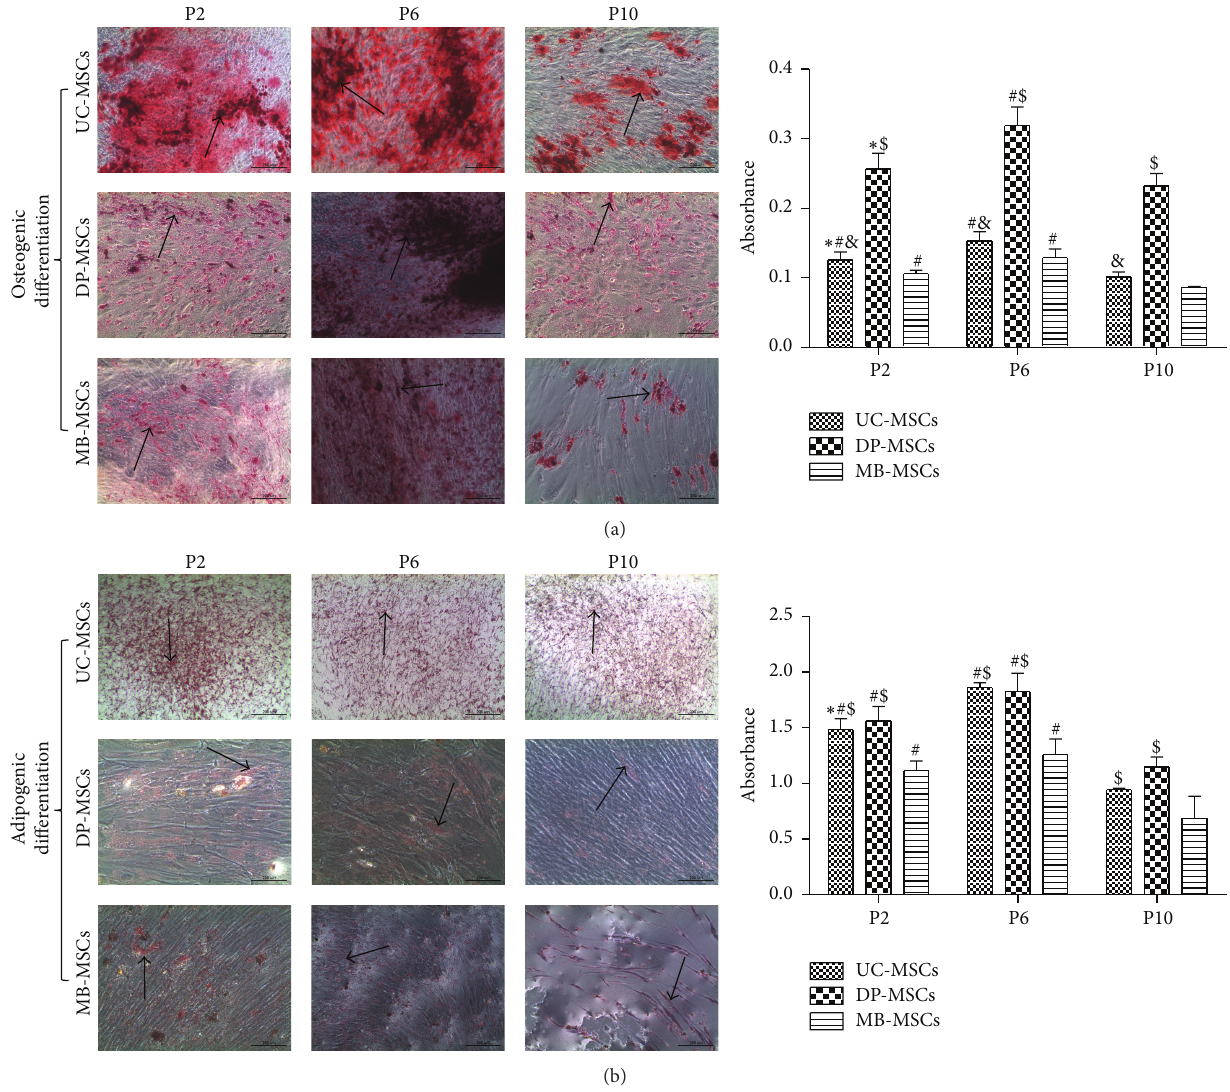
Figure 2: Multidifferentiation of UC-, DP-, and MB-MSCs. (a) Osteogenic differentiation, in which the cells were stained with Alizarin red (100x); (b) adipogenic differentiation in which the cells were stained with Oil Red O (100x). The differentiation capacity was semiquantified by enzyme immunoassay analyzer. Each experiment was performed in triplicate: ∗ compared with P6 of corresponding MSCs; # compared with P10 of corresponding MSCs; & compared with DP-MSCs at corresponding passage; $ compared with MB-MSCs at corresponding passage, 𝑝 < 0.05 . UC-MSCs: umbilical cord mesenchymal stem cells; DP-MSCs: dental pulp mesenchymal stem cells; MB-MSCs: menstrual blood mesenchymal stem cells; P: